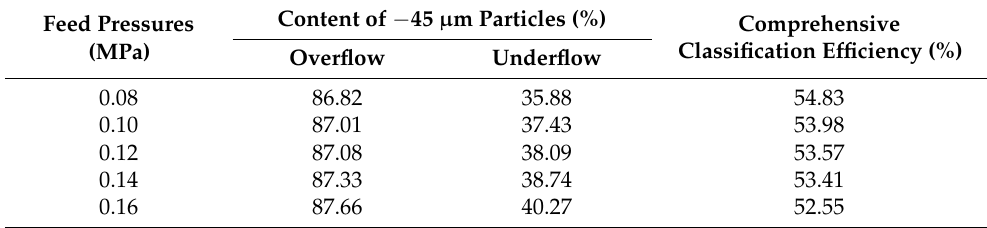
Table 10. Effect of the feed pressure on the classification performance of the